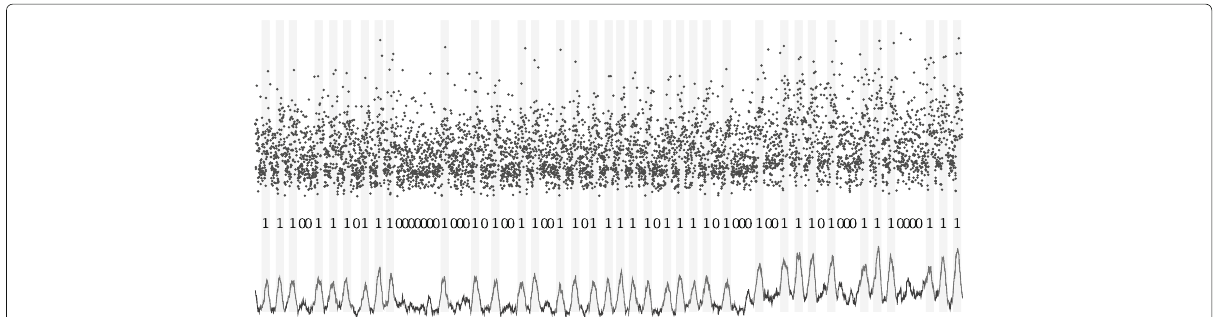
Fig. 7 On top is one trace’s raw measurement over 4000000cycles. The peaks in the resampled trace on the bottom clearly indicate